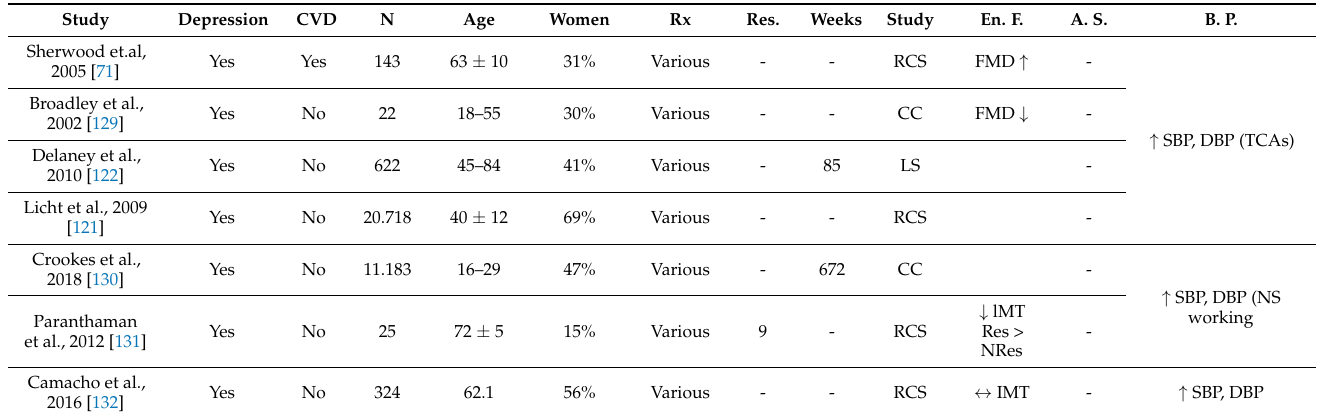
Table 4. The effects of antidepressants on vascular markers: Retrospective Cohort Studies (RCS), Cross-sectional Cohort (CC), and Longitudinal Studies